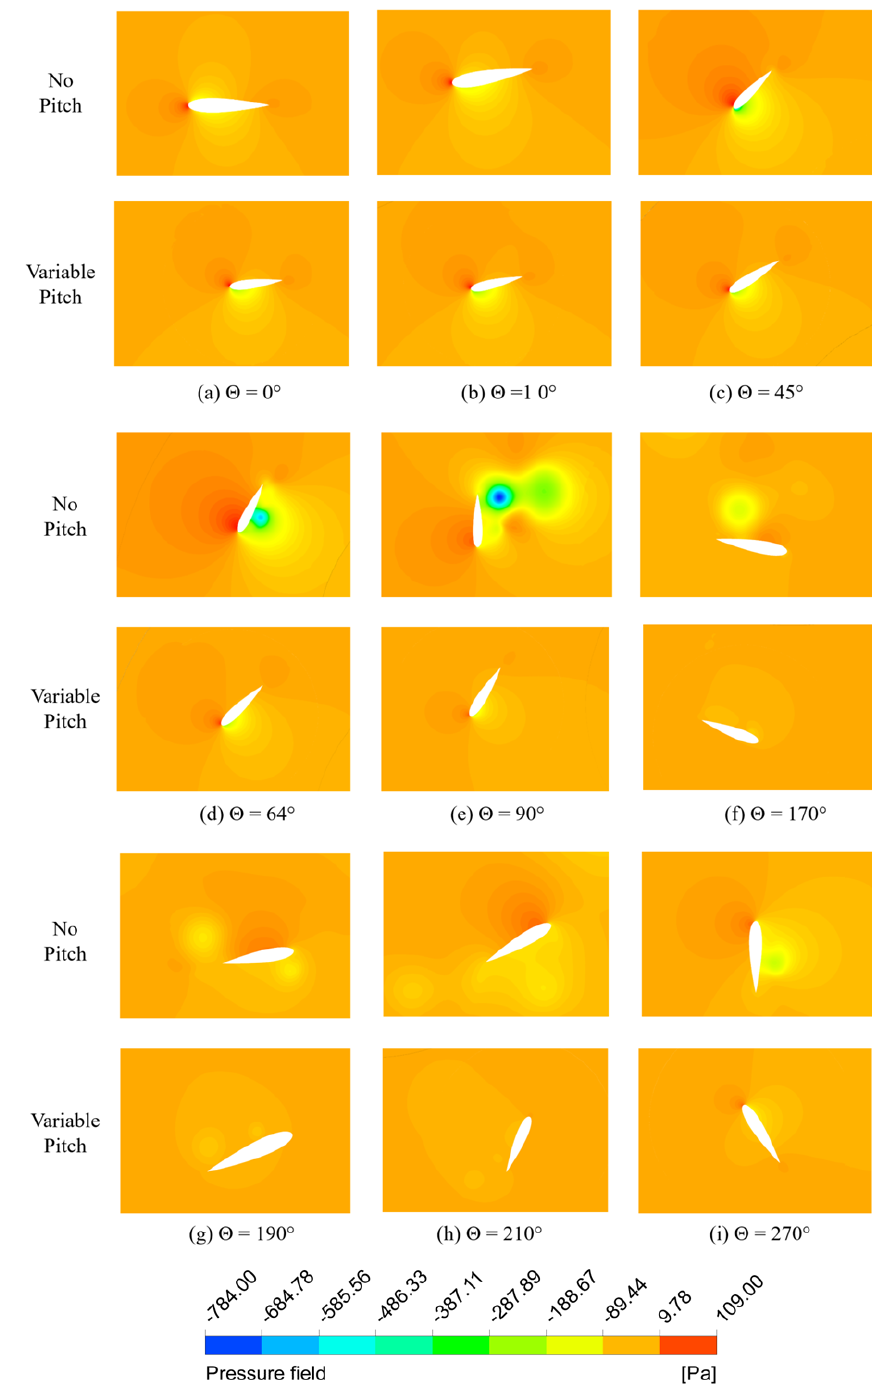
Figure 15. Pressure field around the no-pitch and variable-pitch blades at different azimuthal